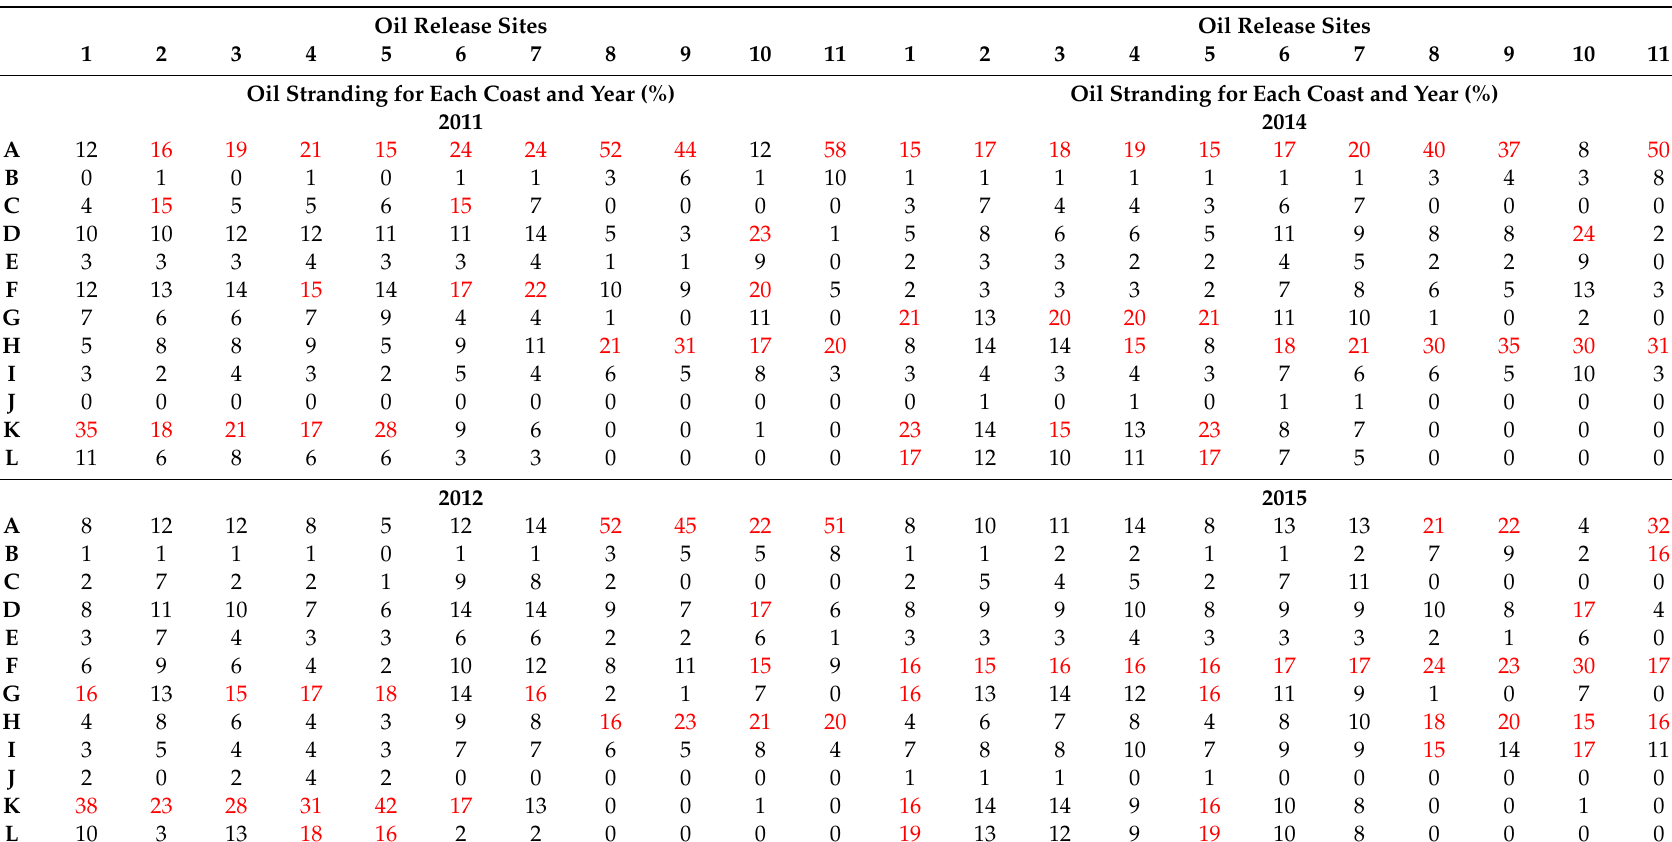
Table 2. Annual percentages (%, red fonts mark the cases greater than 15%) of oil elements released from the 11 study points stranded at specific coastlines: A: N